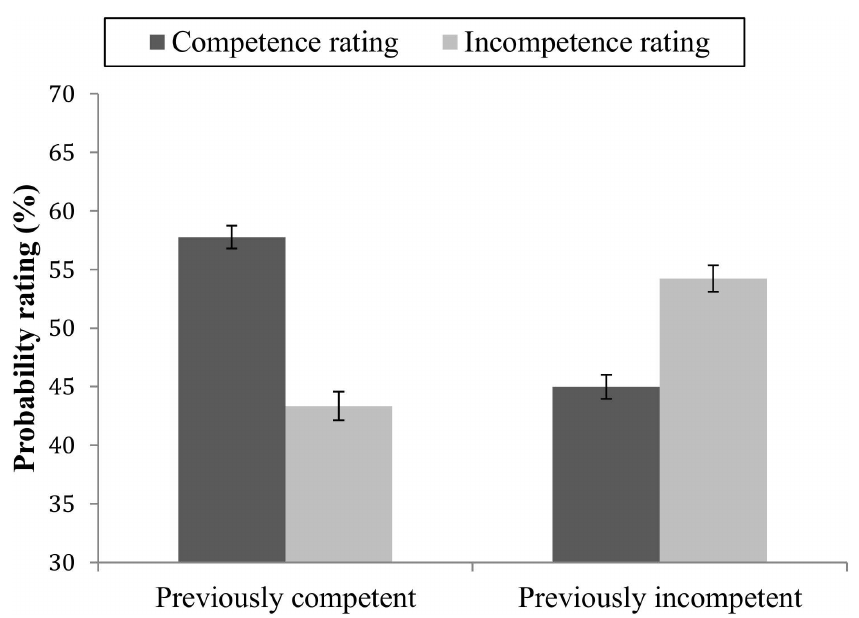
Fig 4. Mean probability ratings of future competent and future incompetent behaviors. Ratings of targets with previously mainly competentor mainly incompetent behavior. Error bars represent standard